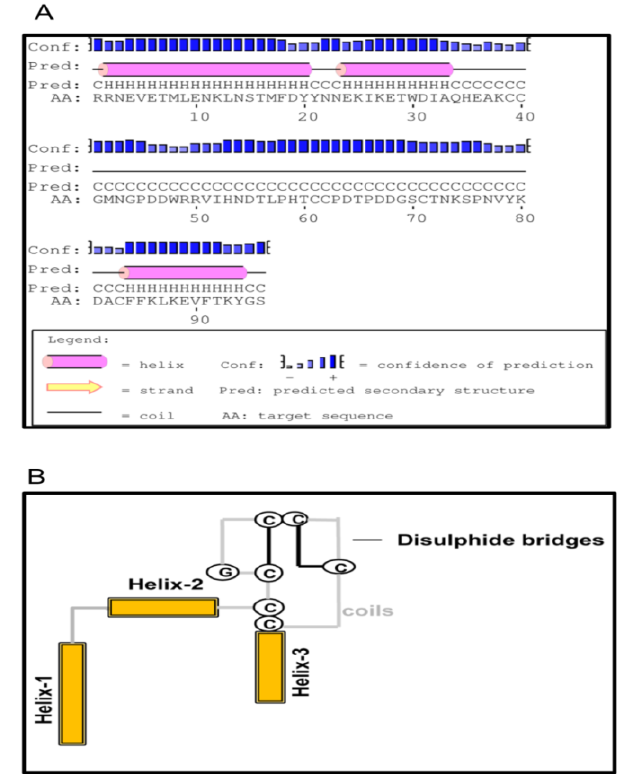
Figure 6. Modeling of LEL topology of TmCD63. ( A ) Secondary structure prediction of TmCD63 LEL using PSI-PRED software. The helical regions (three in number) are demarcated by an extensive coil region that encompasses the mushroom-like structure, characteristic of tetraspanin superfamily; and ( B ) Schematic representation of TmCD63 LEL topology containing six cysteine